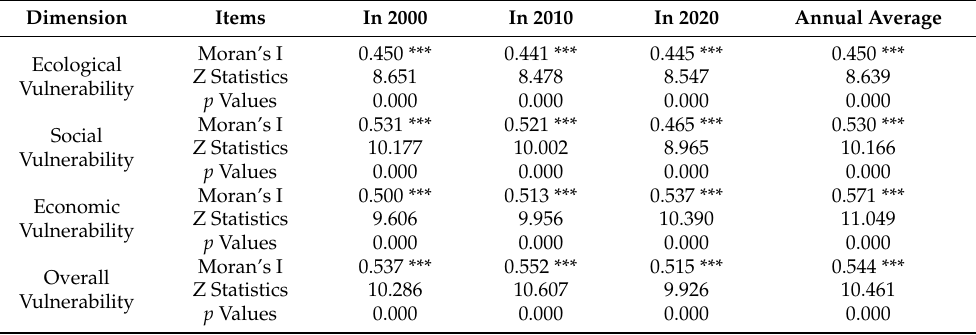
Table 6. Moran’s I Calculation Results of Various Types of Rural Vulnerability in Yunnan Province from 2000 to